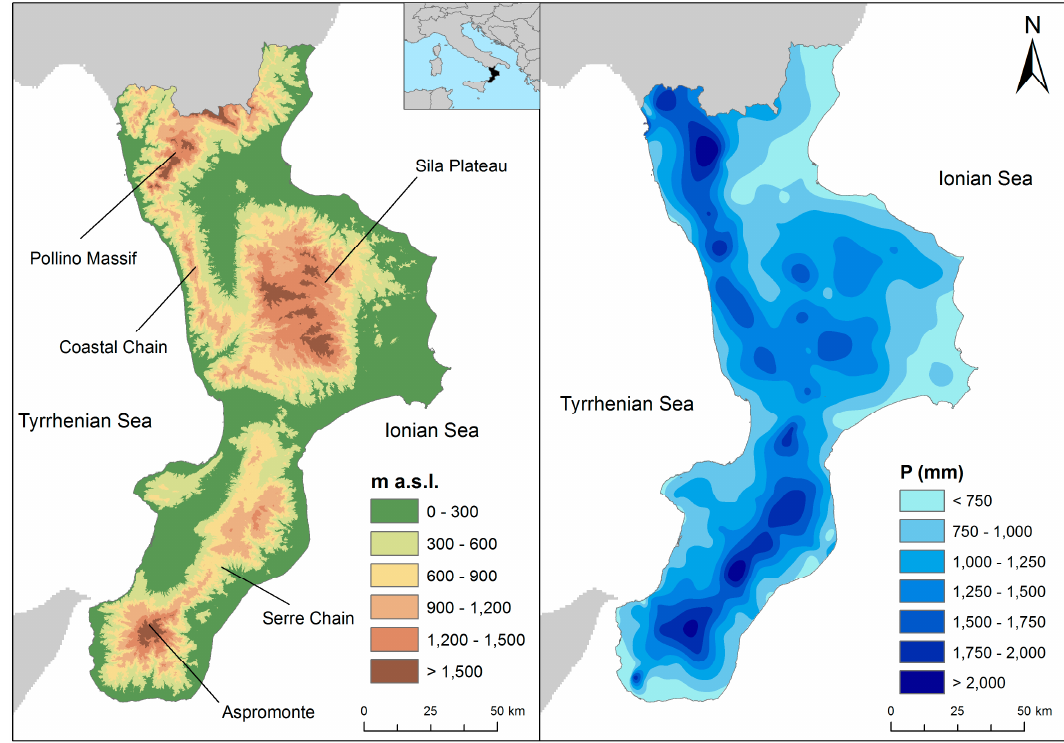
Figure 1. Digital elevation model ( left ); and annual rainfall ( right ) of Calabria region (Italy).